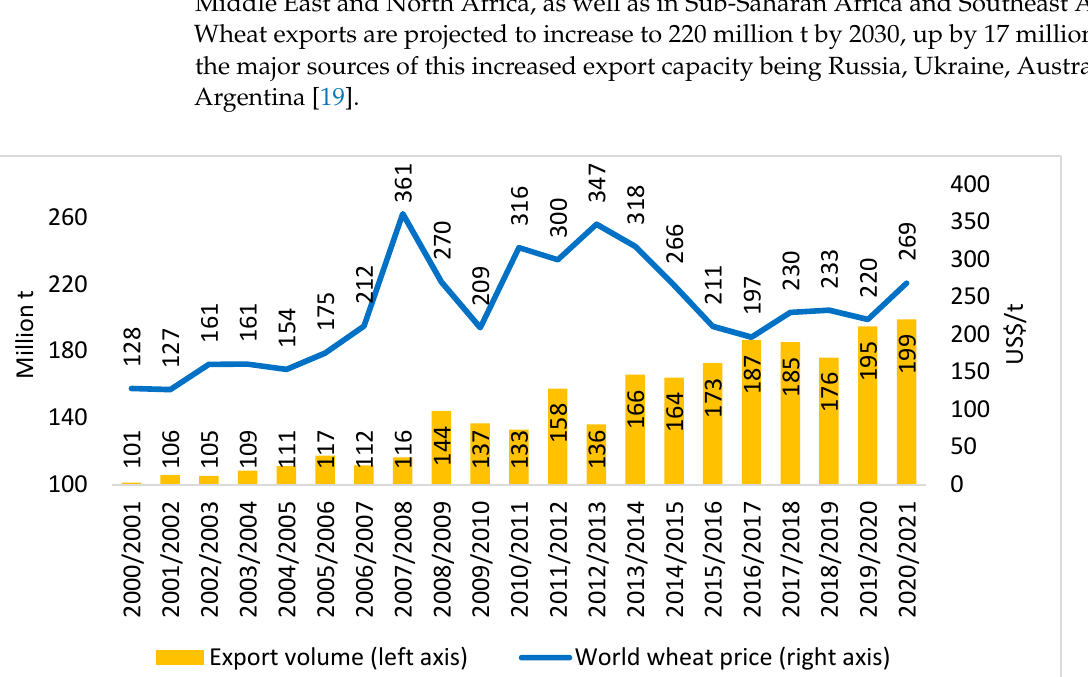
Export volume (left axis) World wheat price (right axis) Figure 1. World wheat exports and prices (2000–2020). Note: World wheat price is represented by the American export price of no. 2 hard red winter wheat at the USA Gulf ports in Louisiana. Data source: [1,21]. Own illustration.